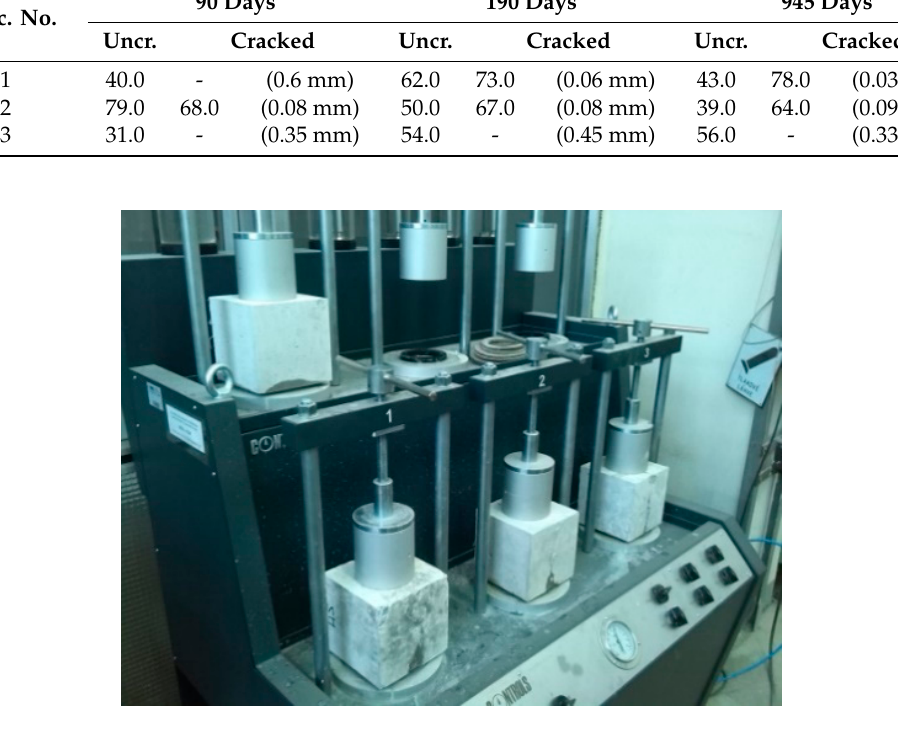
Figure 7. Testing of water penetration in cracked specimens.